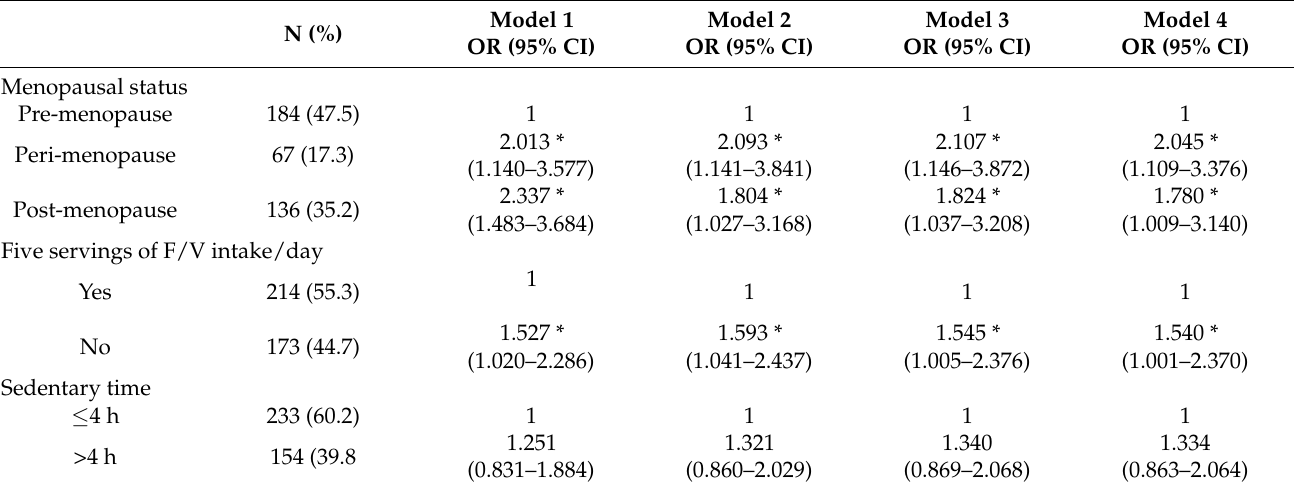
Table 3. Adjusted OR for the independent association of menopausal status, F/V intake and sedentary time of women with central